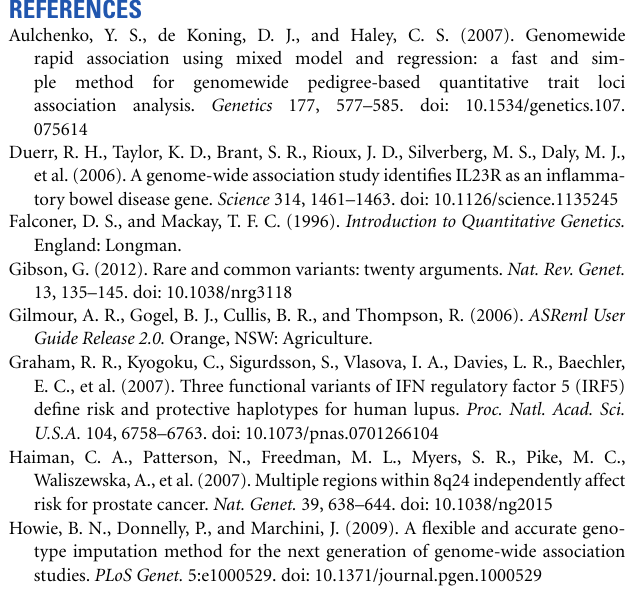
Table S1 | Descriptive statistics for Axial Length, Central Corneal Thickness, and Spherical Equivalent Refraction. Table S2 | SNP number and the average distance between SNPs by chromosome. Table S3 | Estimated genome heritability for Regional heritability mapping (RHM) in the high_info group of the simulation